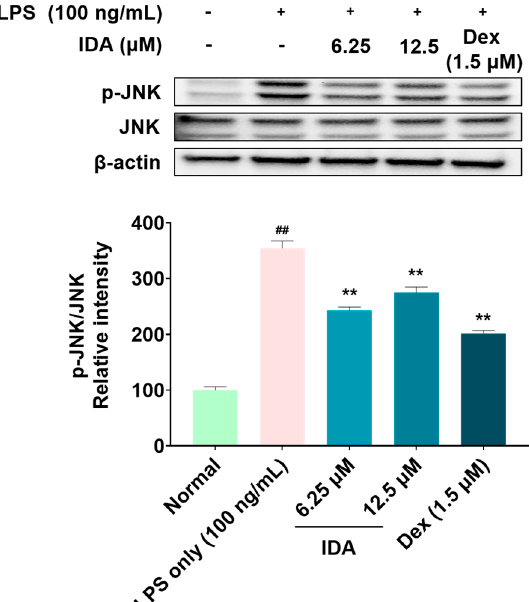
Figure 5. Effect of isodorsmanin A (IDA) on the phosphorylation of c-Jun N-terminal kinase (JNK) in macrophages. Cells were pretreated with IDA (6.25 or 12.5 µ M) for 3 h and then stimulated with 100 ng/mL of LPS for another 2 h. Western blot results are from duplicate independent experiments. The results in the graphs are presented as the mean ± standard error from triplicate measurements. ** p < 0.01 indicates significant differences vs. the LPS-only group. ## p < 0.01 indicates significant difference vs. Normal group. Dexamethasone (Dex); positive control.